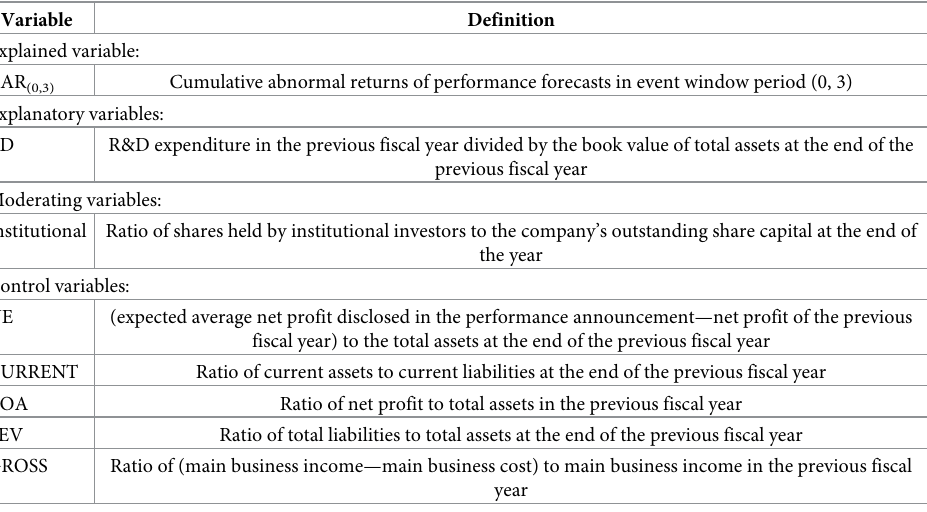
Table 1. Variable